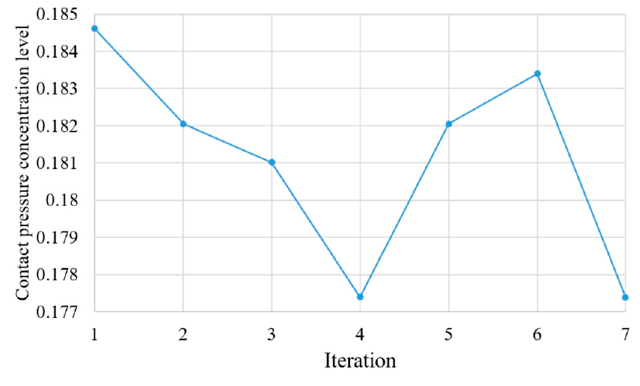
Figure 13. Changes in the value of objective function during the optimization process.